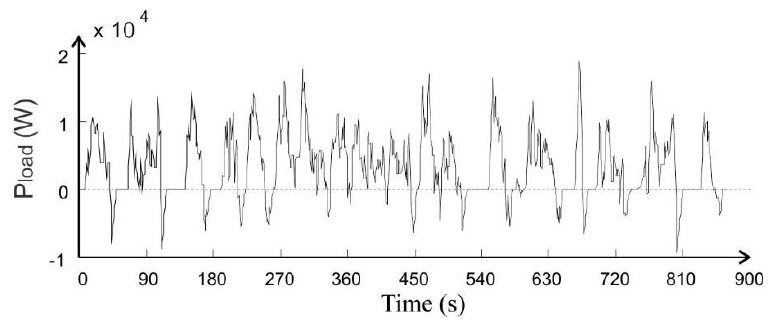
Figure 8. Speed profile of the CITY driving cycle. Appl. Sci. 2020 , 10 , x FOR PEER REVIEW